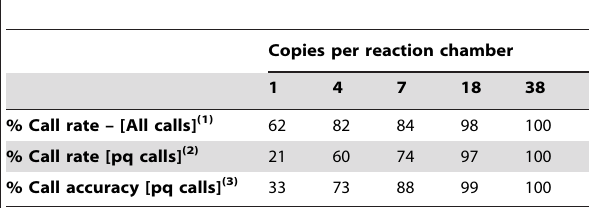
Table 2. Effect of DNA copy number on reliability of genotype call data for a heterozygous human genomic DNA sample,